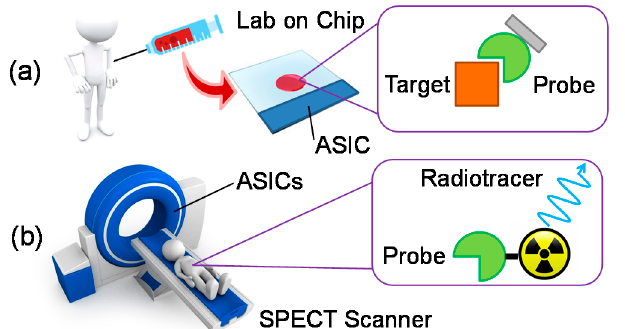
Figure 1. Complementary scenarios of the application of application specific integrated circuits (ASICs) in non-invasive medical diagnostics based on molecular specificity: ( a ) point-of-care analysis on a microfluidic chip and ( b ) single-photon emission tomography (SPECT) nuclear imaging in a clinical scanner.